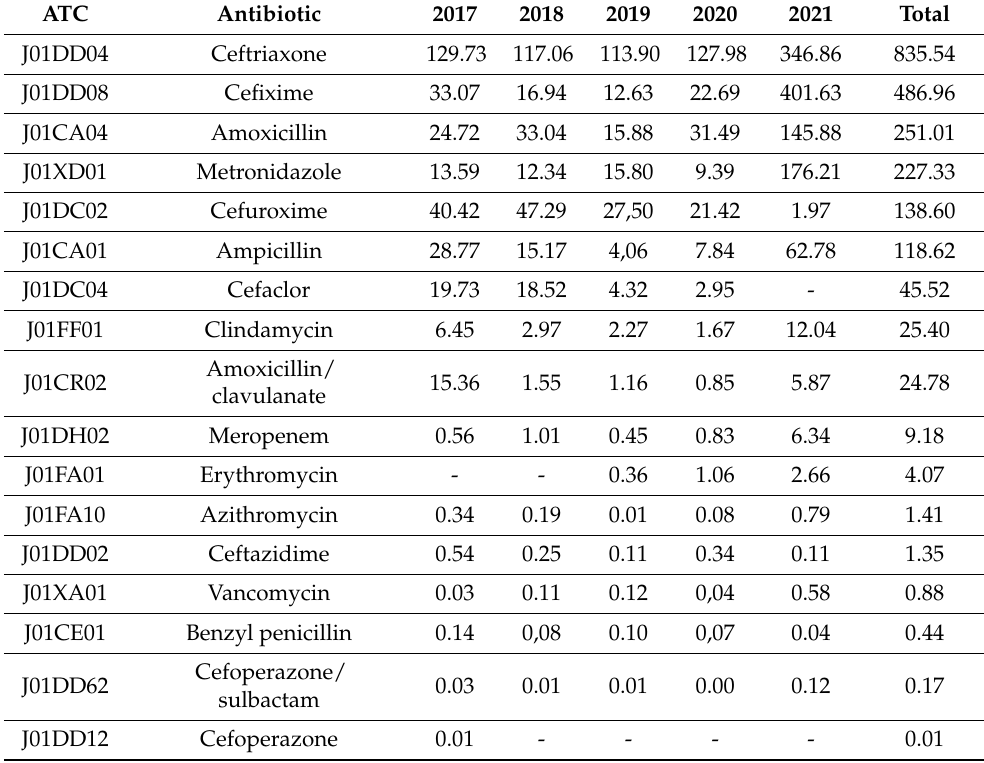
Table 5. FDA category B antibiotics commonly prescribed expressed in DDDs/100 bed days.